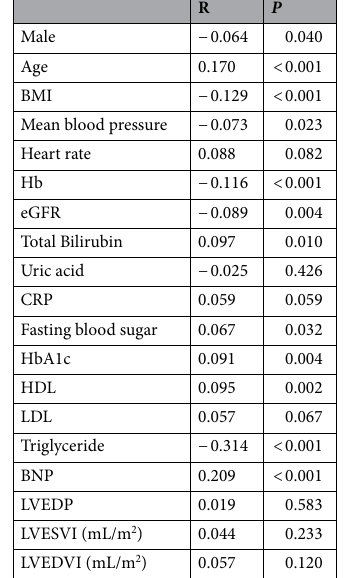
Table 2. Spearman’s rank correlation coefficients between the total ketone body level and various clinical factors (n = 1030). BMI body mass index, Hb hemoglobin, eGFR estimated glomerular filtration rate, CRP C-reactive protein, HDL high-density lipoprotein cholesterol, LDL low-density lipoprotein cholesterol, BNP B-type natriuretic peptide, LVEDP left ventricular end-diastolic pressure, LVESVI left ventricular end-systolic volume index, LVEDVI left ventricular end-diastolic volume